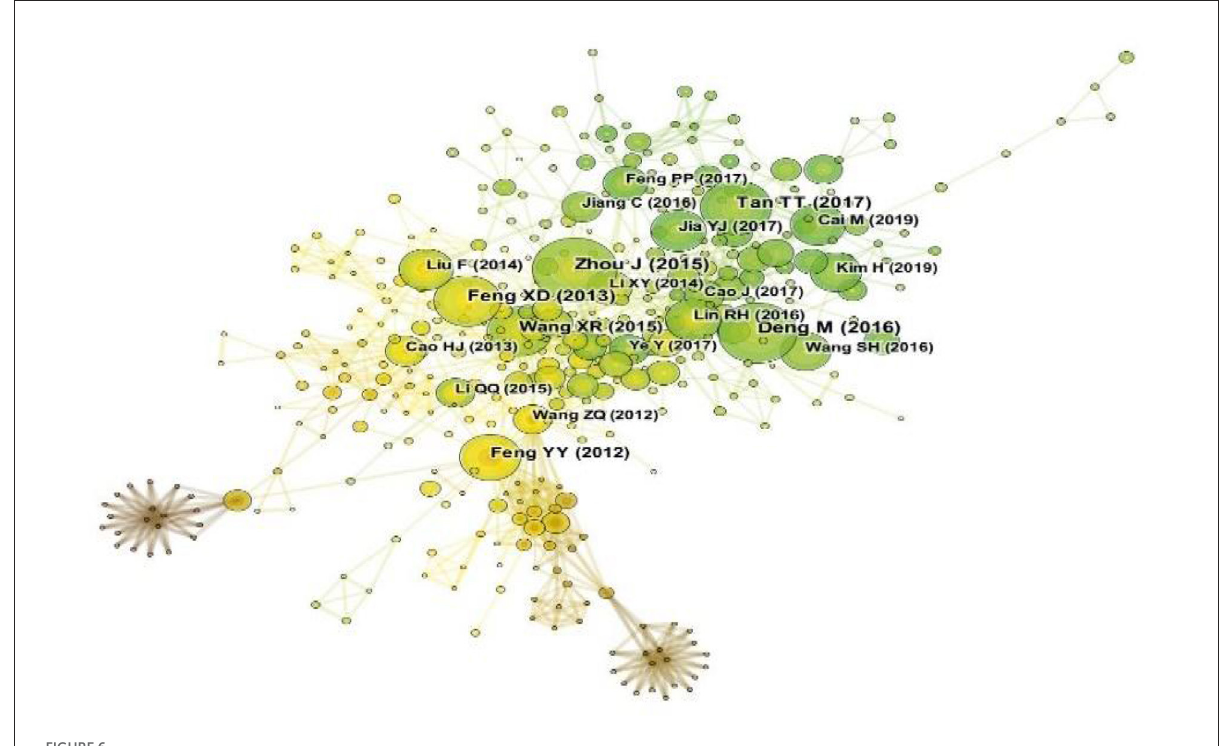
FIGURE6 Map of co-citation journals.